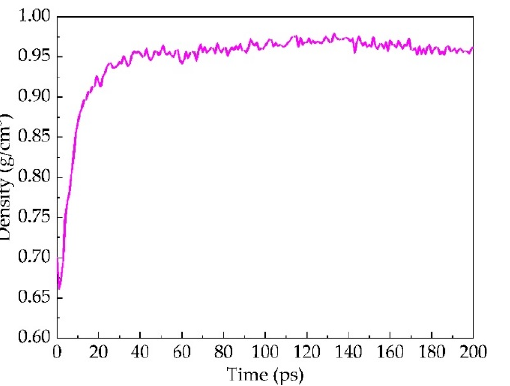
Figure 5. The dependence of density as a function of time for the old and new asphalt system.